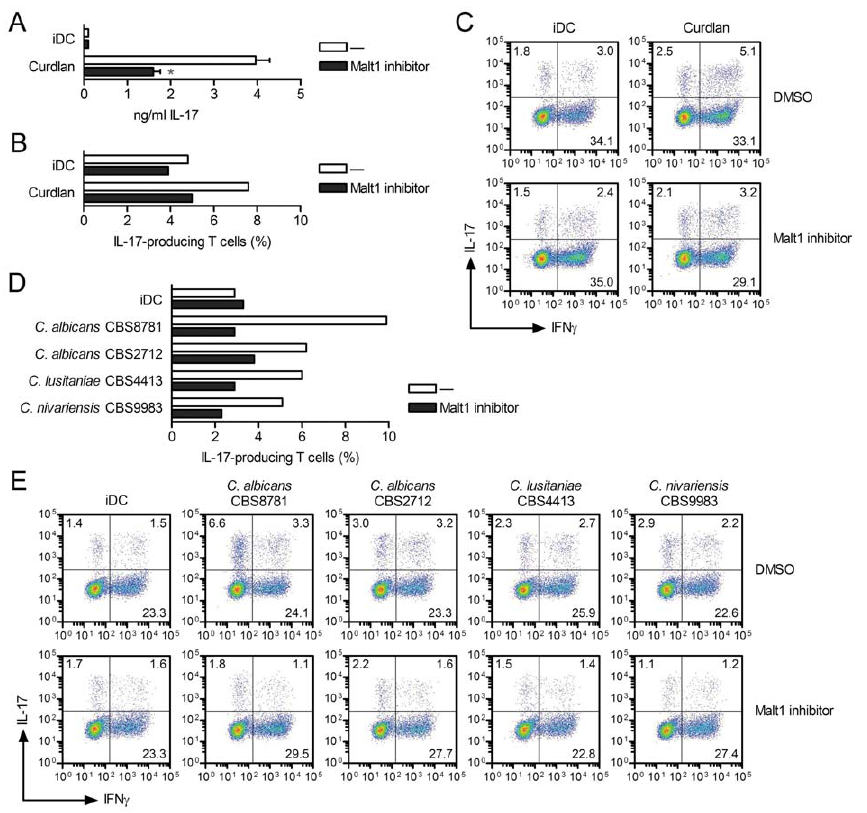
Figure 7. Malt1 signaling skews T helper cell polarization towards T H -17. (A–E) T helper cell polarization was assessed by ELISA by measuring IL-17 production in supernatants at day 5 (A) or by flow cytometry by staining for intracellular IL-17 or IFN c expression at day 12 after PMA plus ionomycin restimulation (B–E), after co-culture of memory CD4 + T cells with DCs left unstimulated (iDC) or primed with curdlan (A–C) or Candida spp. (D and E) in the absence or presence of Malt1 paracaspase inhibitor z-VRPR-FMK. In (B) and (D) the percentage of IL-17-producing T cells are shown, corresponding to the upper left and right quadrants of (C) and (E), respectively. Data are mean 6 s.d. of duplicate cultures, * p , 0.05 (Student’s t -test), and are representative of three (A) or two (B–E) independent